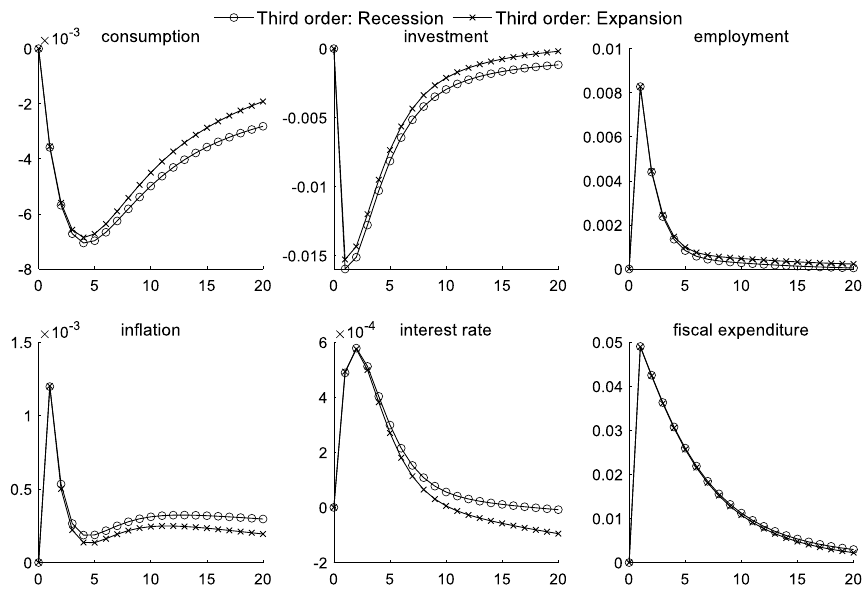
Fig. 5 Impact of uncertainty risk on fiscal policy shocks in different economic